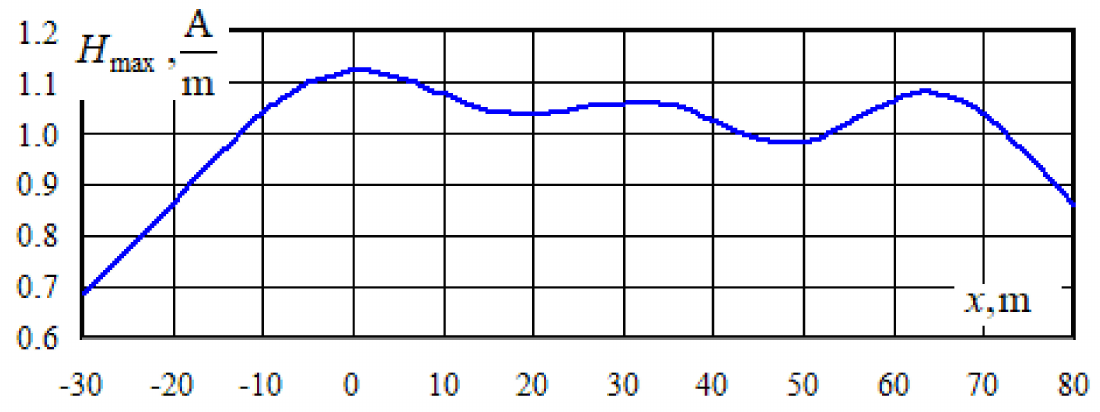
Figure 14. Losses as a function of transmitted active power.